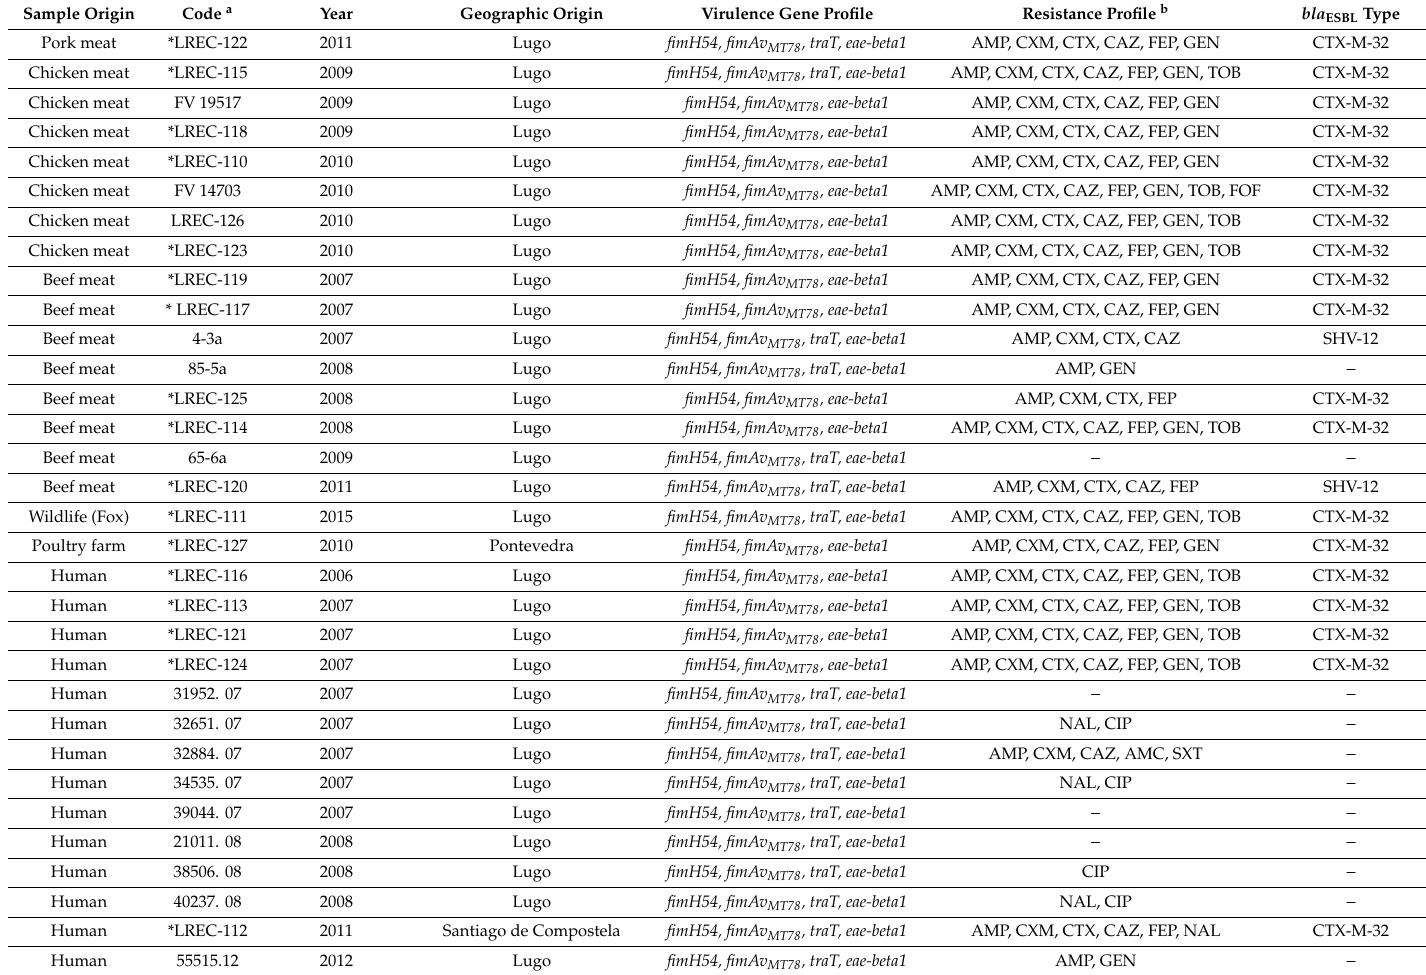
Table 1. Phenotypic and genotypic characterization of 32 aEPEC O153:H10-A-ST10 (CH11-54)